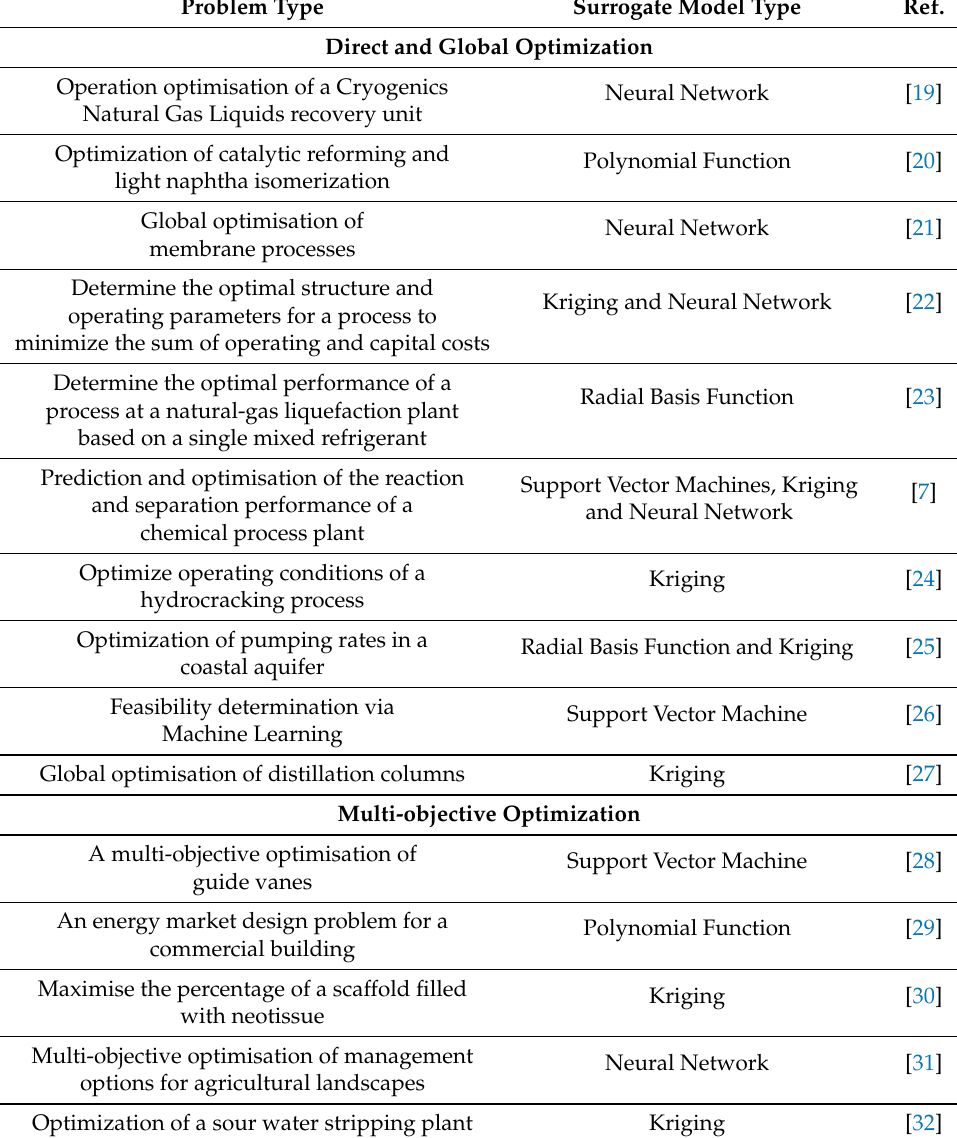
Table 2. The applied surrogate model types for different application